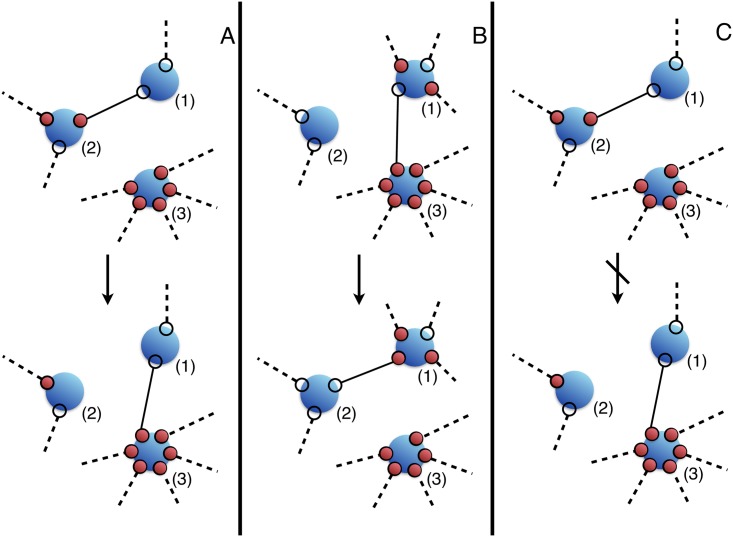
Dynamics of social interactions.Move A is promoted by power alone: (3) is much richer than (1) and (2) thus it will take the quantum of wealth they share. Move B and C on the contrary are promoted by frustration as in Eq (7). In B (3) is not frustrated but (1) and (2) are, thus the probability for them to reorganize their neighborhood is increased. Move C is suppressed by the social friction implicit in Eq (7).